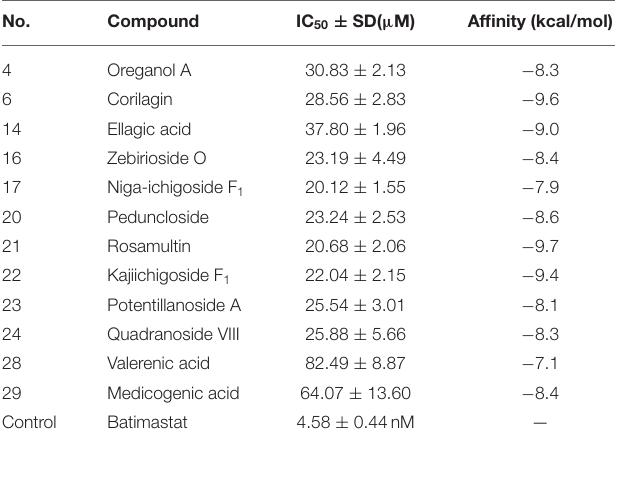
TABLE 2 | Inhibitory effects of MMP-2 binding ligands.